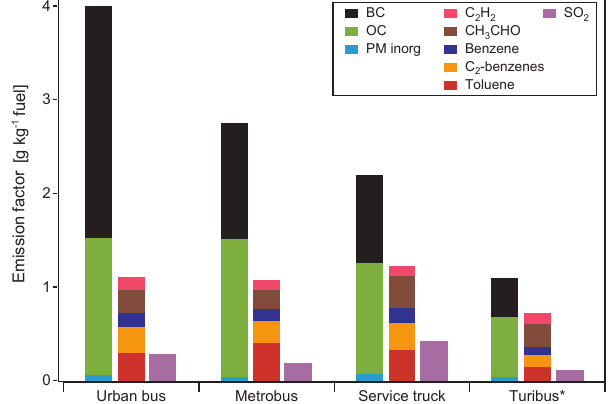
Figure 3. Box plots of PM emission factors measured by control technology. The numbers in parenthesis represent the number of sampled vehicles. Upper vertical central lines, upper level box lines, middle horizontal lines, lower box lines, and lower vertical central lines represent 90, 75, 50, 25, and 10% of the data. The first box plot of the EPA98 technology category includes the high emitter vehicle UB1 (see Table 2), whereas the adjacent box plot does not include this vehicle. PM was obtained as the sum of BC, OC, chlorides, ammonium, sulfates, and nitrate components measured by the SP-